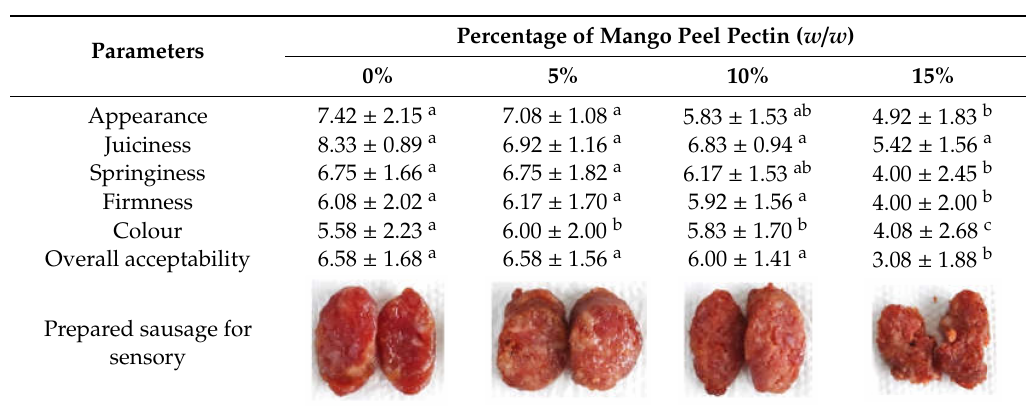
Table 4. Sensory analysis of dried Chinese sausage with added mango peel pectin at di ff erent levels with 9-points hedonic scale